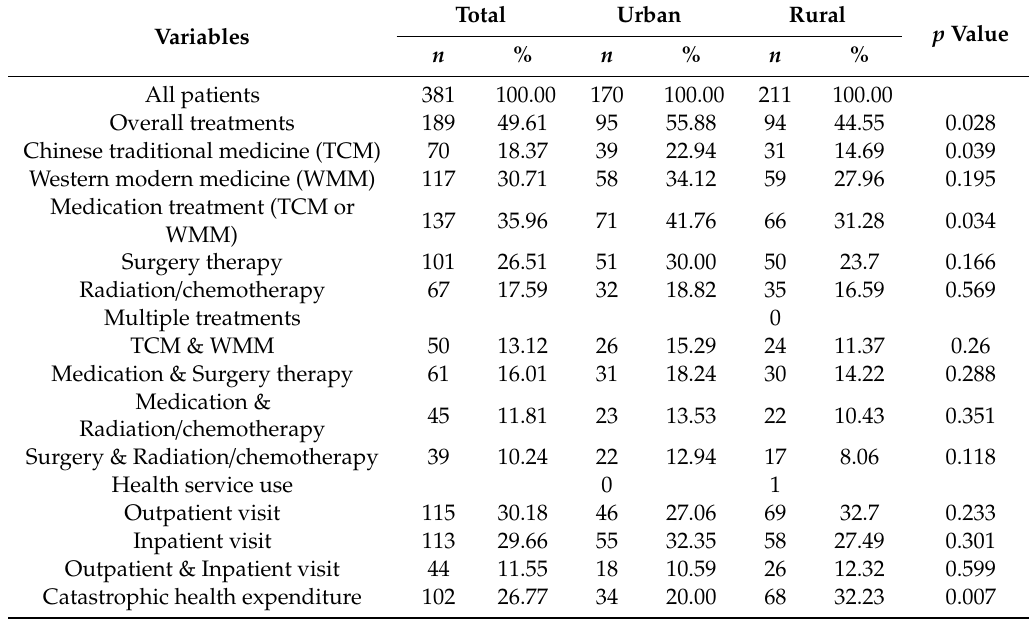
Table 2. The treatment status among Chinese adults with cancer in 2015, by residence location.